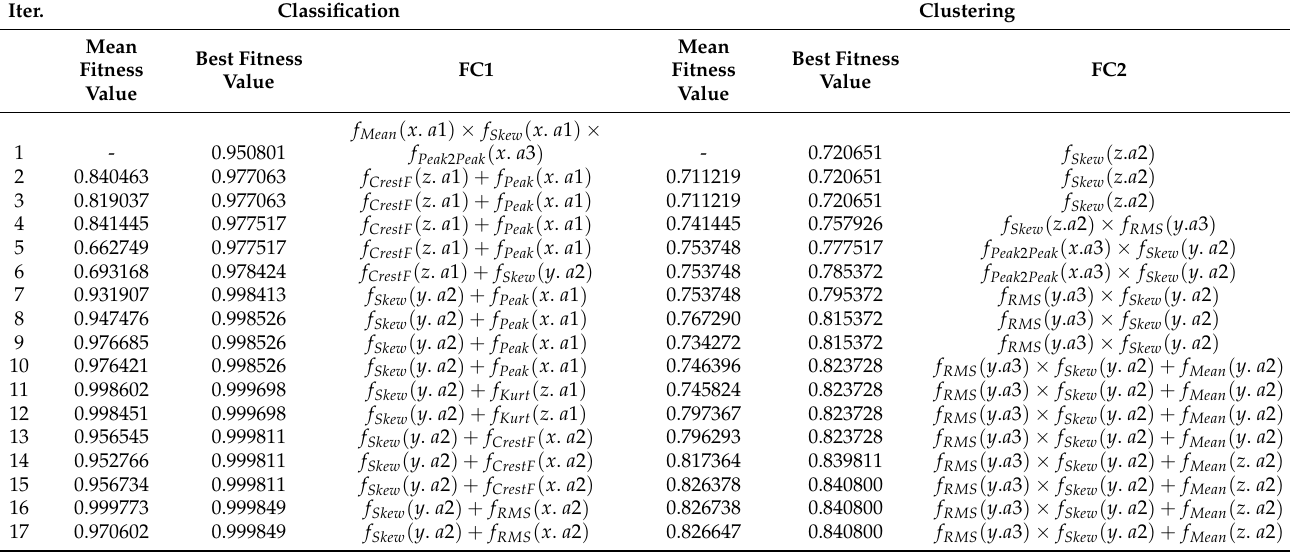
Table 7. Fitness values and mathematical formulation of the feature constructed at each iteration of the best run of classification-based and clustering-based